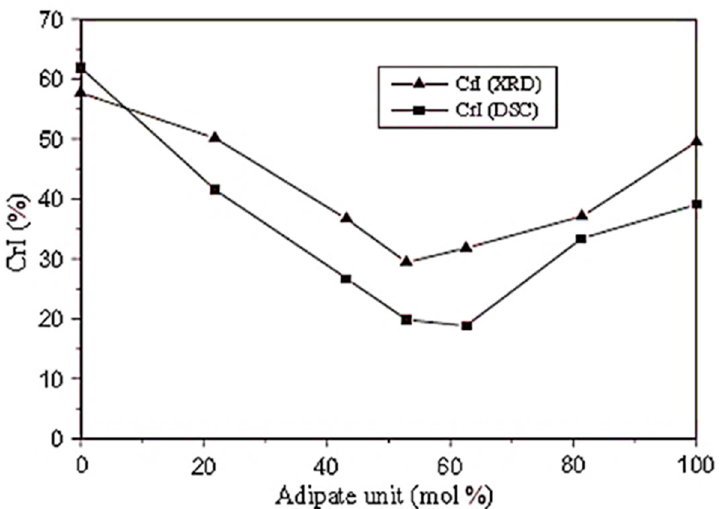
Figure 8. Copolyester crystallinity index as a function of the adipate unit composition [Reprinted with permission from Reference [45] Copyright 2006 Elsevier].